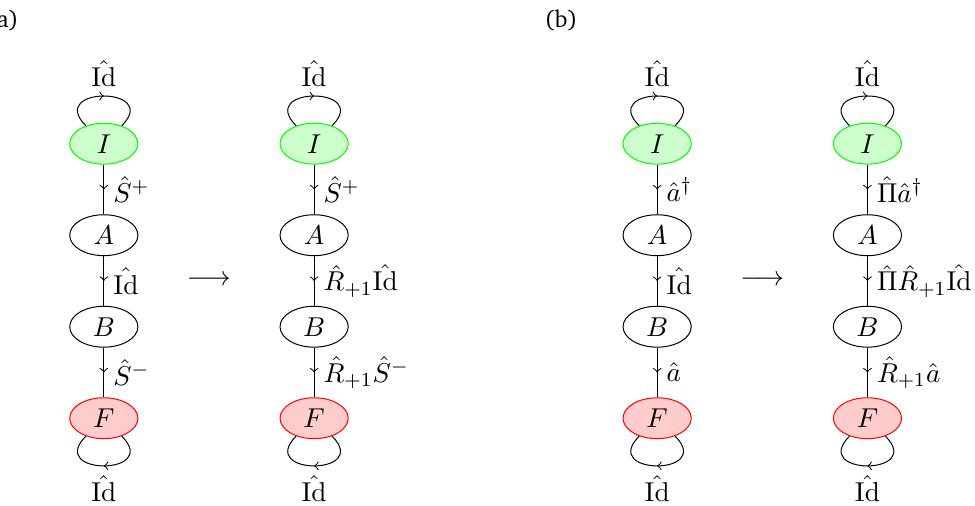
Figure 6: (a) Transformation of local operators ˆ S ± , ˆId to conserve U ( 1 ) quantum numbers in the graph representation Λ ( ˆ H Transformation of local operators ˆ a , ˆ a † , ˆId to conserve U ( 1 ) quantum numbers in the graph representation Λ ( ˆ H nearest-neighbor hopping ˆ H term we